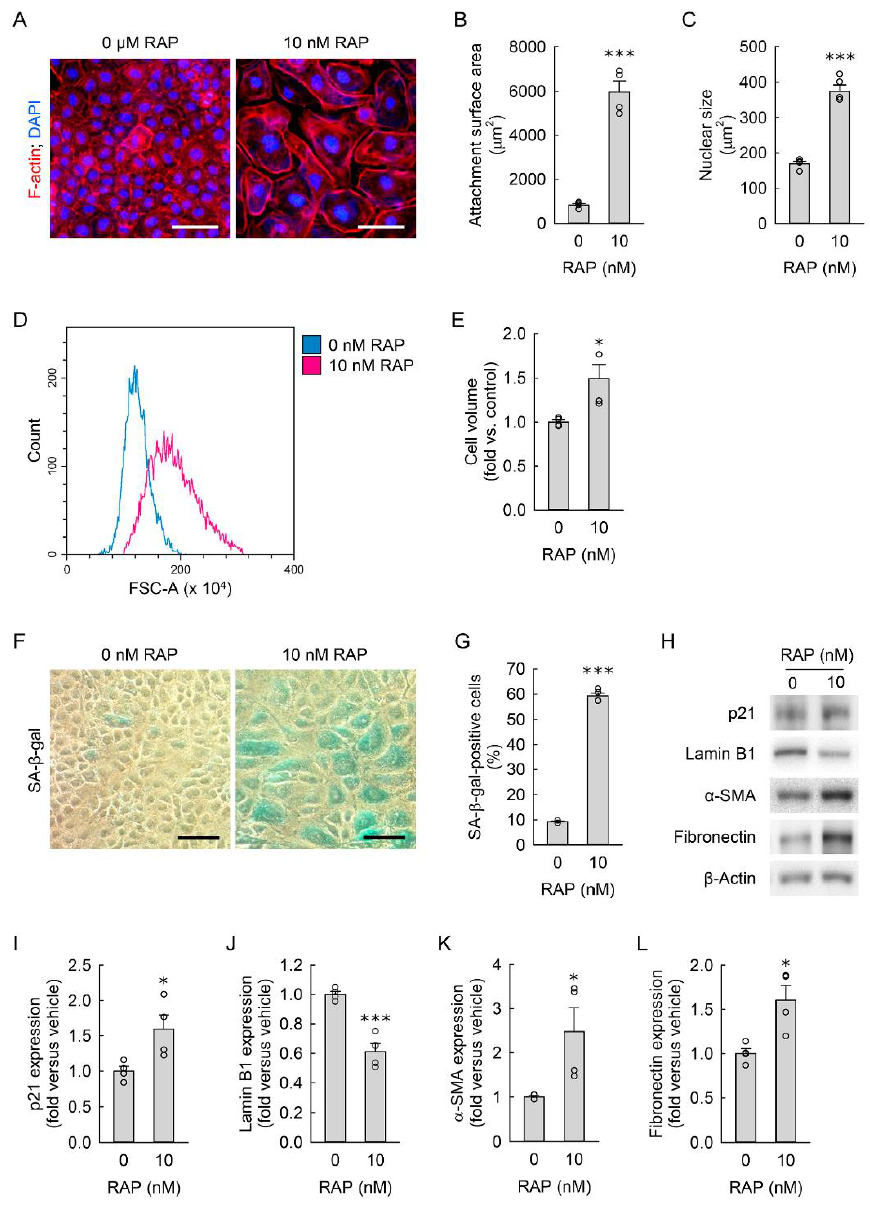
Figure 8. Repeated administration of paclitaxel (RAP) induces cellular hypertrophy and cellular senescence within transformation of kidney fibroblasts into myofibroblasts. Normal rat kidney fibroblast NRK-49F cells were treated with 0 or 10 nM paclitaxel, a microtubule-stabilizing agent, in normal culture media for 6 h, and the media were replaced with normal culture media, followed by incubation for 18 h. The experiment was repeated three times, and finally, the cells were harvested at 72 h after first treatment. ( A ) Representative images of F-actin-stained cells at × 400 magnification using the Nikon Eclipse Ni upright microscope (Nikon, Tokyo, Japan), DS-Ri2 camera (Nikon), and NIS-Elements imaging software (Nikon). Total cellular DNA was stained with 4 (cid:48) ,6-diamidino-2- phenylindole (DAPI). Scale bar, 50 µ m. ( B , C ) Quantifications of cell attachment surface area from F-actin staining and cell nuclear size from DAPI staining at × 200 magnification using NIS-Elements imaging software ( n = 4 experiments). ( D ) Representative histogram of forward scatter area (FSC- A) using the CytoFLEX flow cytometer (Beckman Coulter, Indianapolis, IN, USA) and CytExpert software (Beckman Coulter). ( E ) Cell volume was defined based on a mean value of forward scatter area using the CytoFLEX flow cytometer and CytExpert software ( n = 4 experiments, 10,000 events per experiment). ( F ) Representative images of senescence-associated β -galactosidase (SA- β